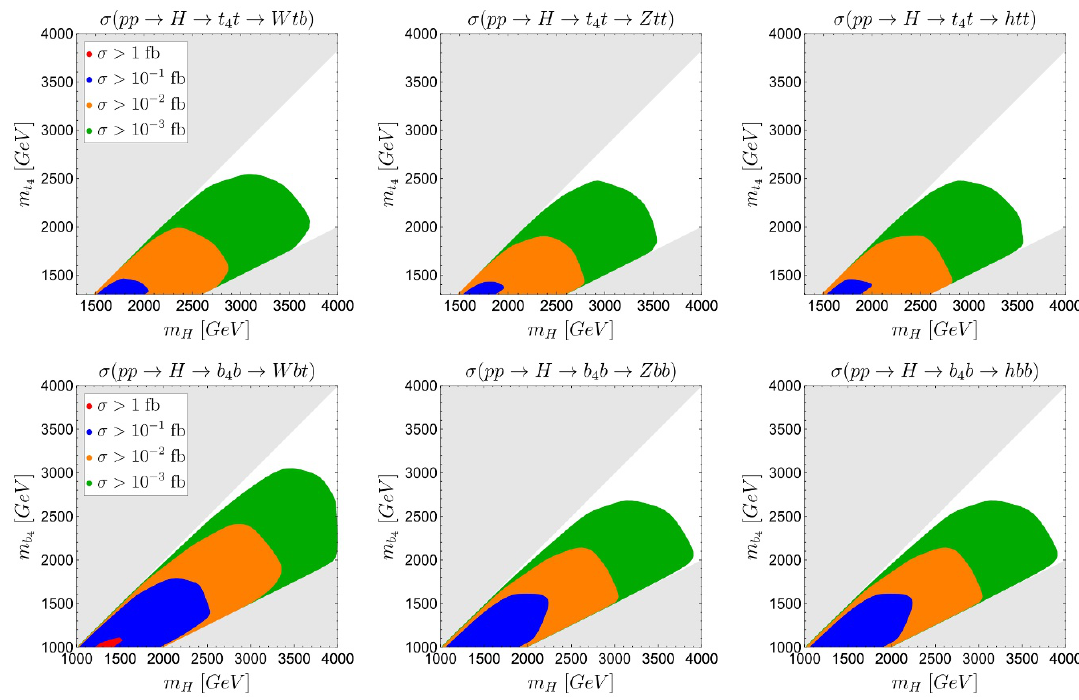
Figure 7 . Maximum production rates of individual (cid:12)nal states in cascade decays of a heavy Higgs boson as functions of m H and m t (top panels) or m b (bottom panels) in the scenario with couplings 4 4 to both H u and H d . In gray shaded regions H ! t 4 t; b 4 b modes are not kinematically allowed or H ! t 4 (cid:22) t 4 ; b 4 (cid:22) b 4 modes are